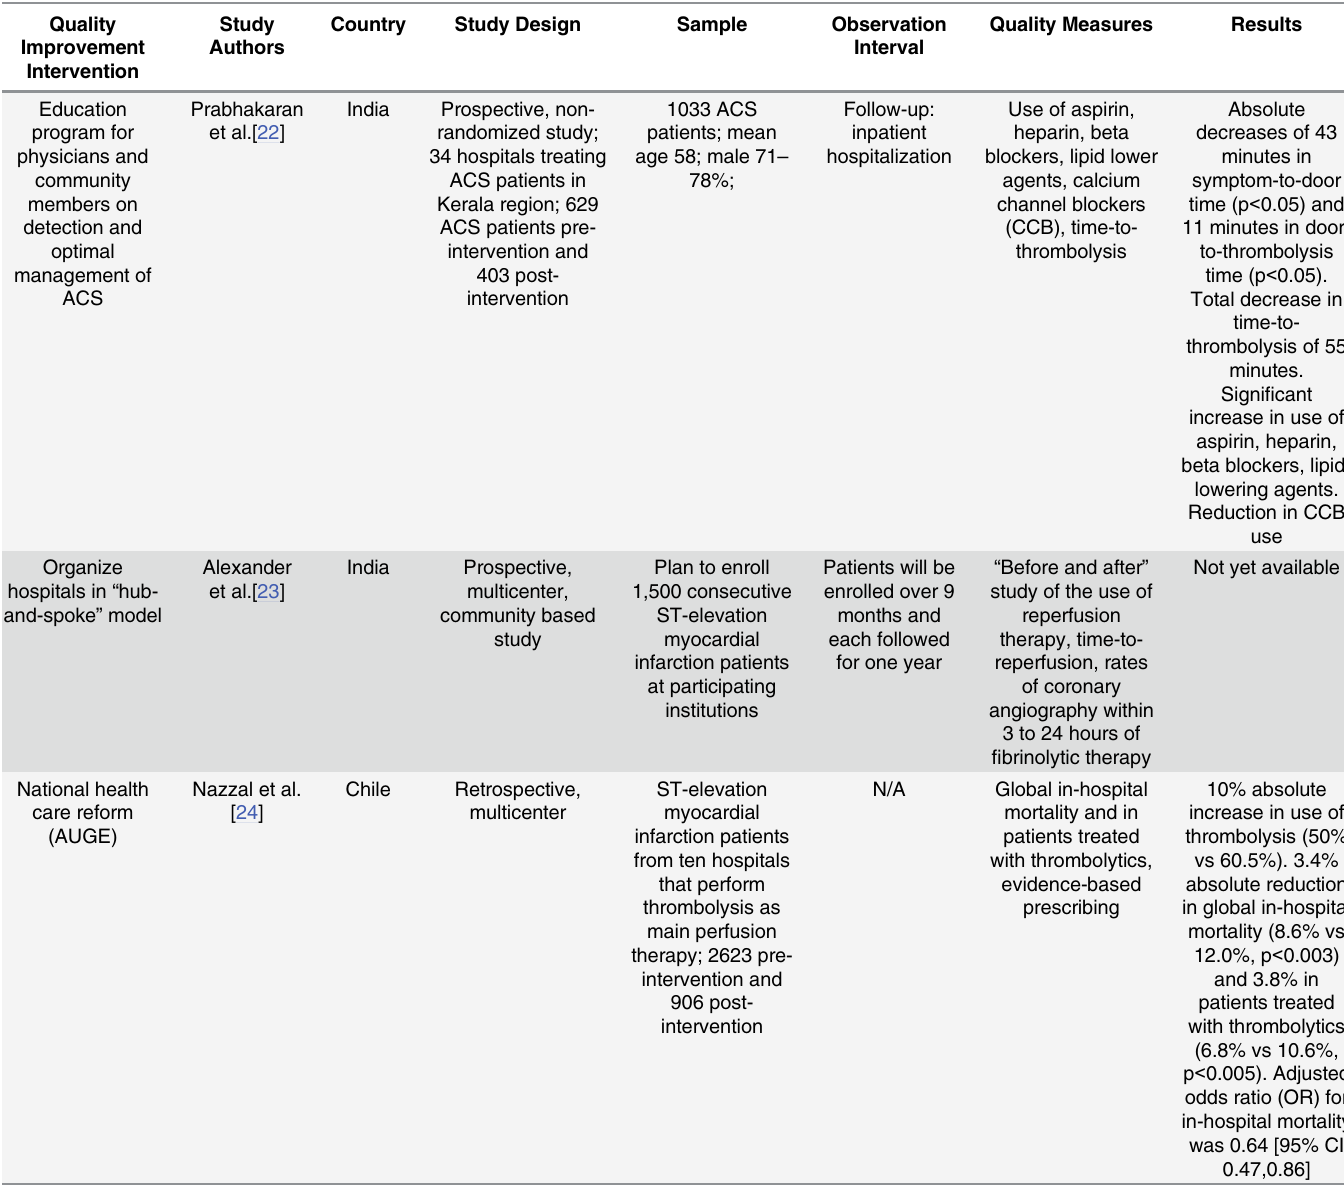
Table 2. System level-acute phase CVD quality improvement studies identified during